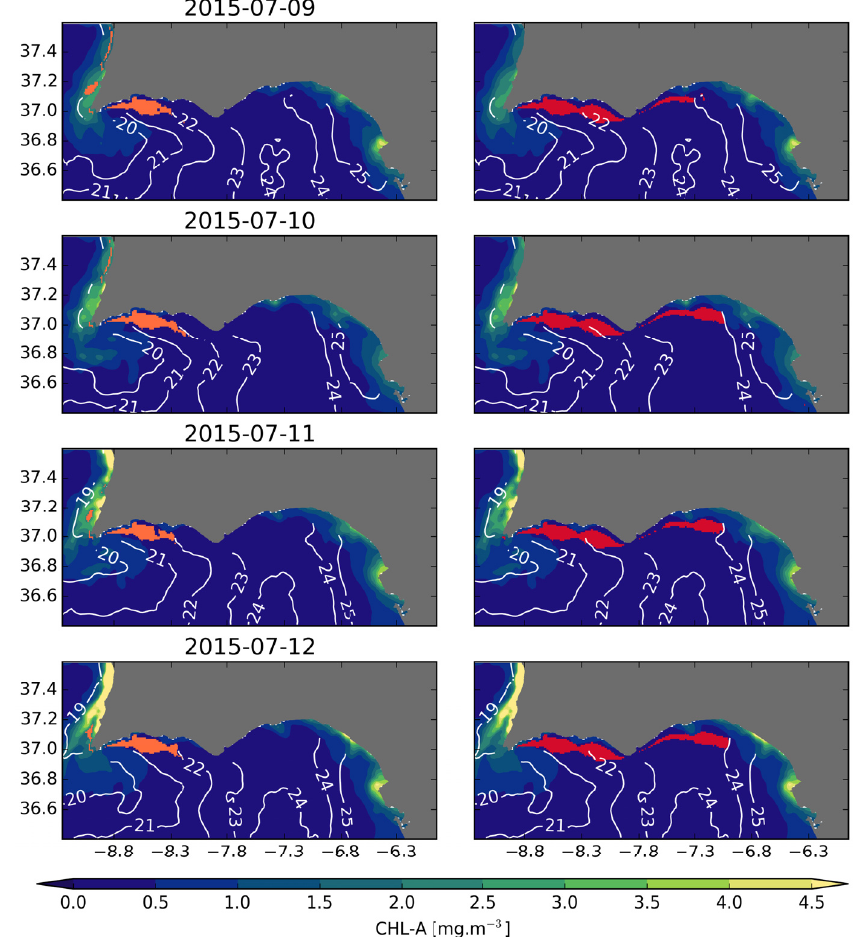
Fig. 6. Daily maps of potential fi shing areas (PFA) showing in orange and red the regions where the daily oceanographic conditions during 9 – 12 July 2015 corresponded to higher catches of sardine (left) and chub mackerel (right) for the SAOI, based on the bivariate SST – Chl-a catch distributions in Figure 4c and d. Chl-a concentrations as colour shadings and SST as isothermals (in °